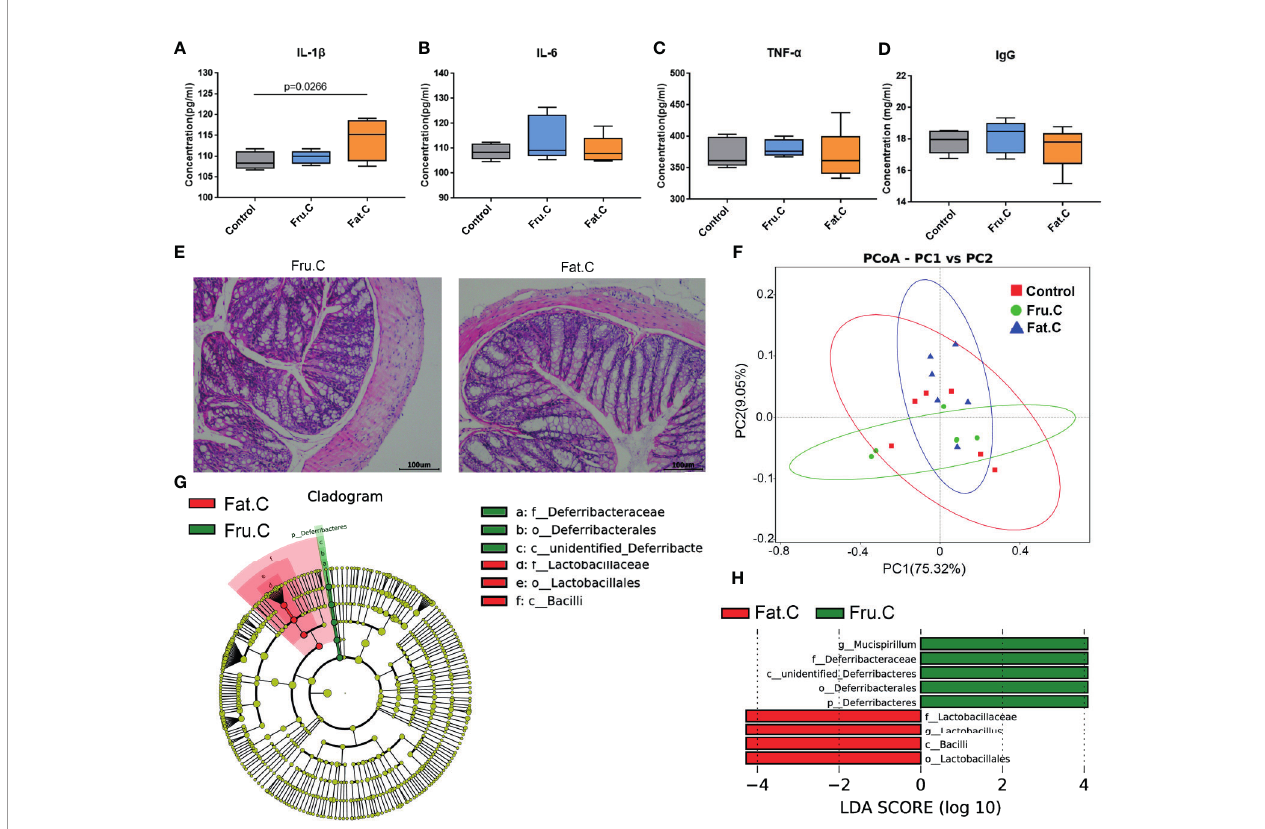
FIGURE 6 | Diet changes the intestinal microbiota and then affects intestinal in fl ammation. Levels of proin fl ammatory serum immune factors, including IL-1 b (A) , IL-6 (B) , TNF – a (C) , and immunoglobulin IgG (D) associated with in fl ammation. H&E staining showed the intestinal state of the experimental group after transplantation of fecal bacteria (E) . Based on the unweighted UniFrac distance PCoA analysis (F) . In the cladogram, the circles radiating from inside to outside represent the taxonomic level from phylum to genus (or species). Each small circle at different taxonomic levels represents a taxonomic level, and the diameter of the small circle is proportional to the relative abundance (G) . The histogram of LDA value distribution shows the species whose LDA score is greater than the set value (the default setting is 4); biomarkers with statistical differences between groups (H) . (Fru.C, high-fructose diet changed to normal diet group; Fat.C, high-fat diet changed to normal diet